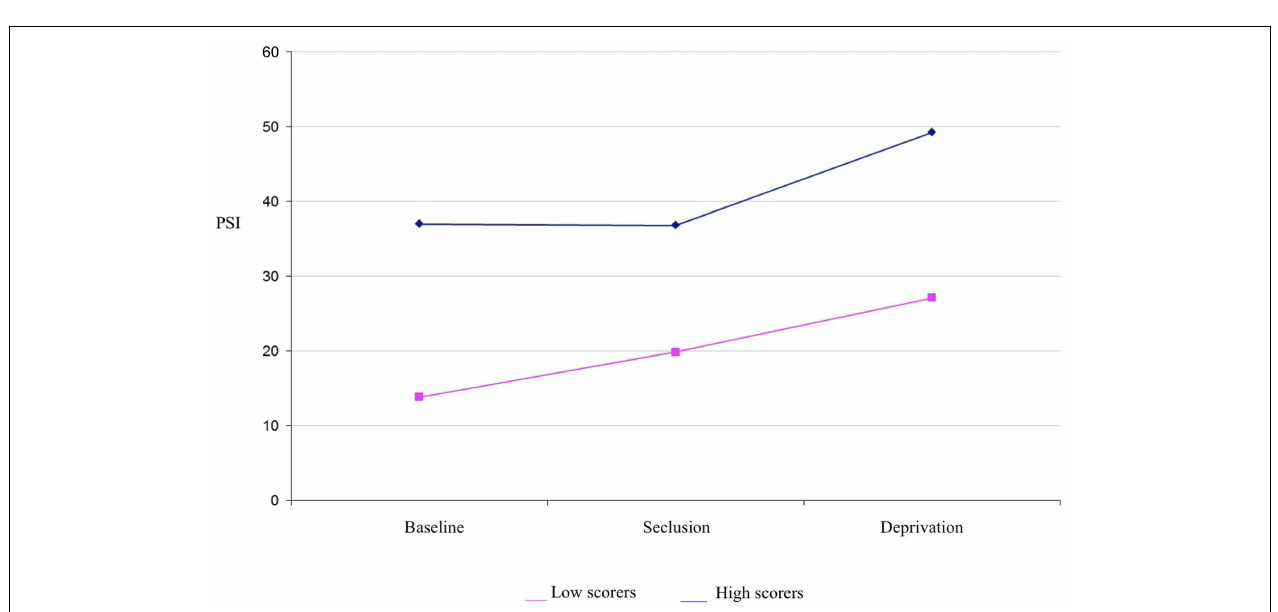
FIGURE 1 | Psychotomimetic states inventory scores in high and low hallucination-prone groups by condition